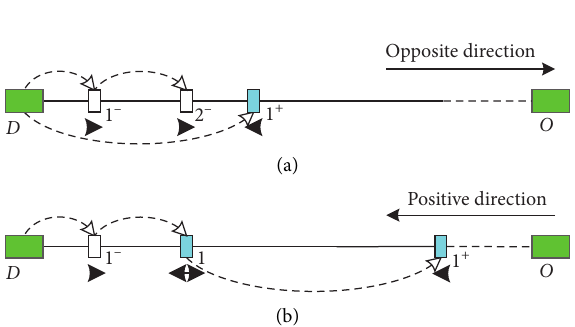
Figure 11: Bidirectional ASA determination based on an ASA of opposite